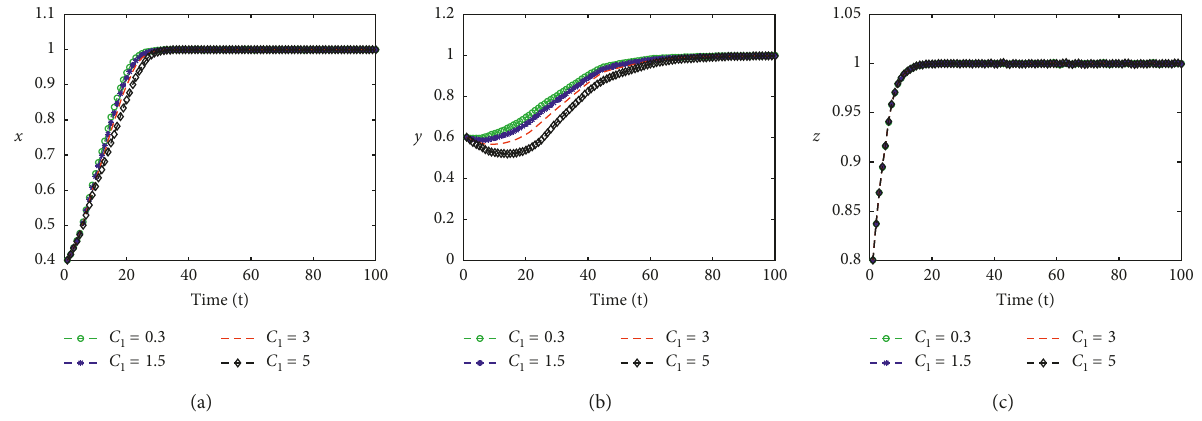
Figure 10: The effect of external investors’ appraisal costs on the evolutionary strategies.